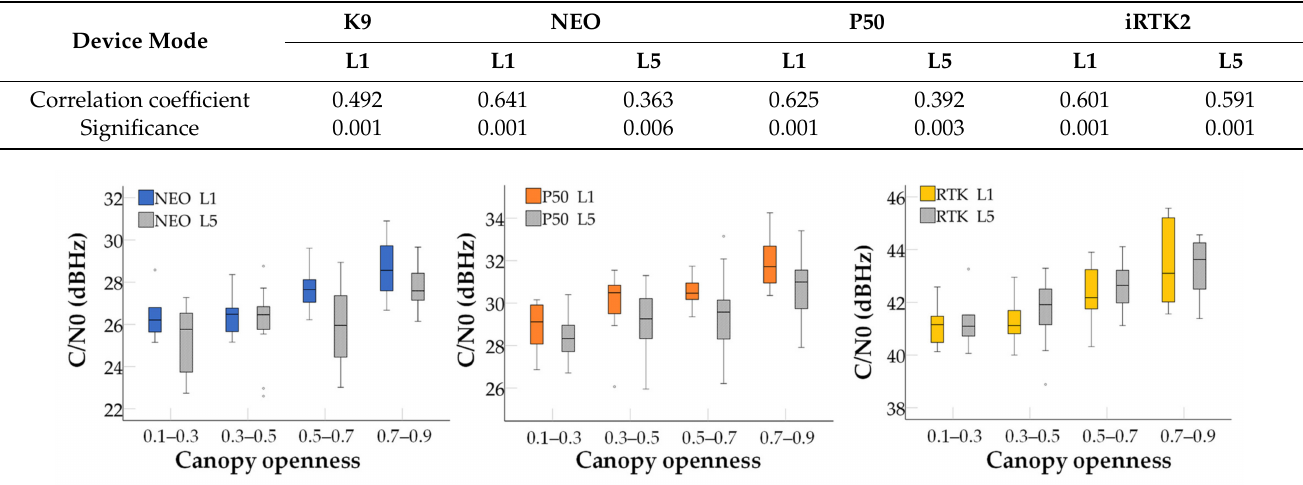
Table 4. Correlation between C/N0 and canopy openness.